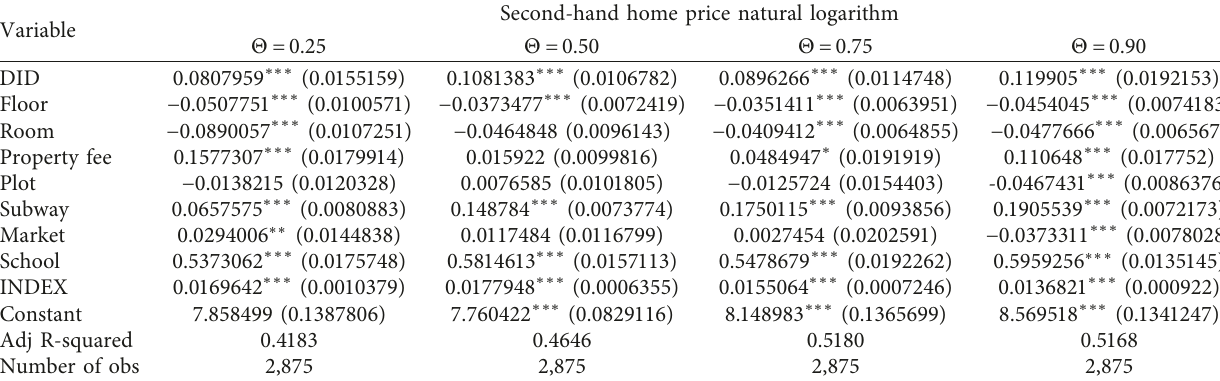
Table 7: Quantile regression results of different value